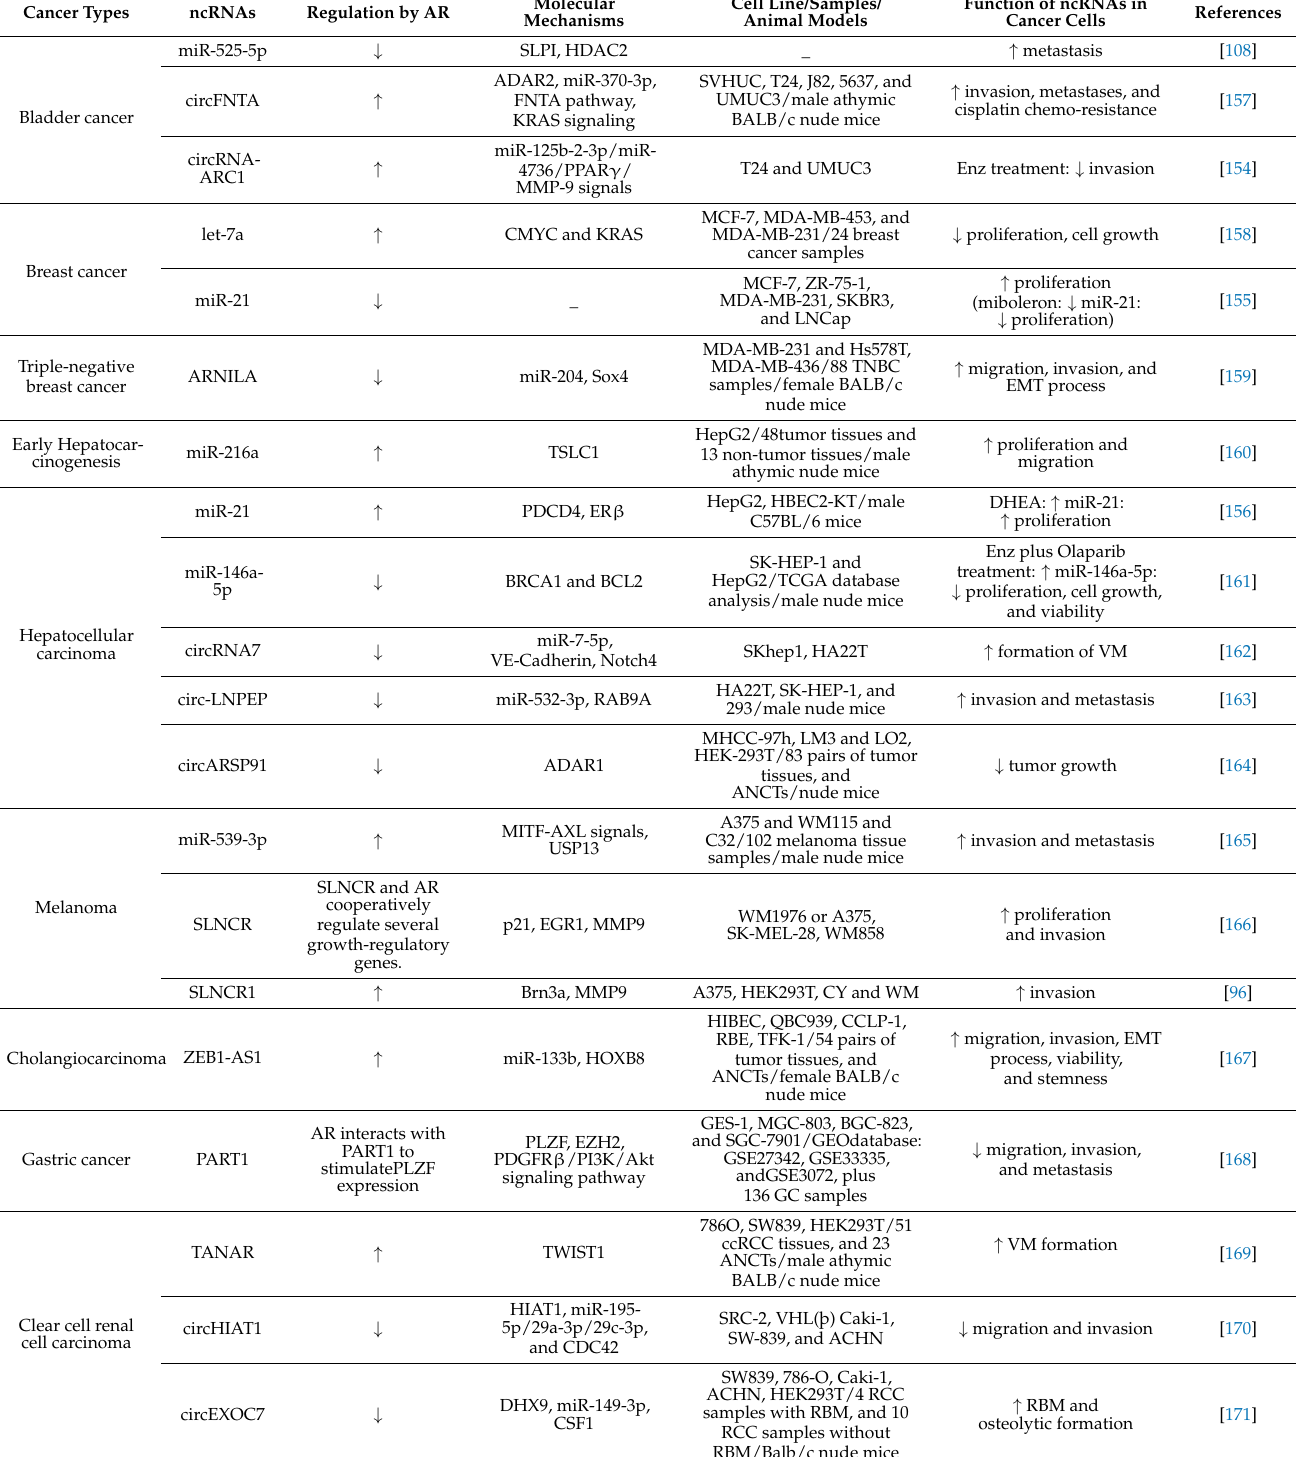
Table 7. Effects of AR on ncRNAs in different cancer types (Enz: enzalutamide, VM: vasculogenic mimicry, DHEA: dehydroepiandrosterone, RBM: ccRCC bone metastases, ↓ : decrease in, ↑ : increase